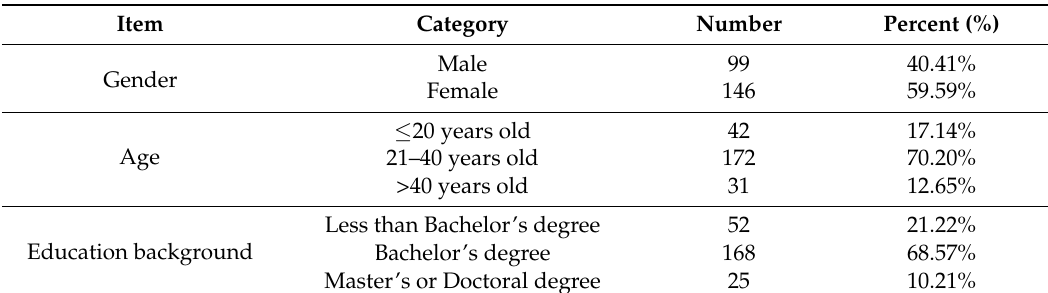
Table 1. Demographic characteristics.